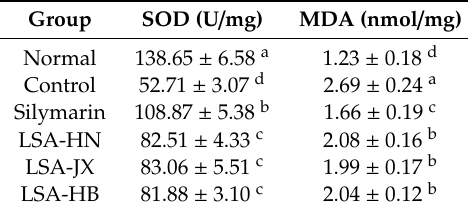
Table 5. The levels of superoxide dismutase (SOD) and malondialdehyde (MDA) in hepatic tissue of mice ( N =